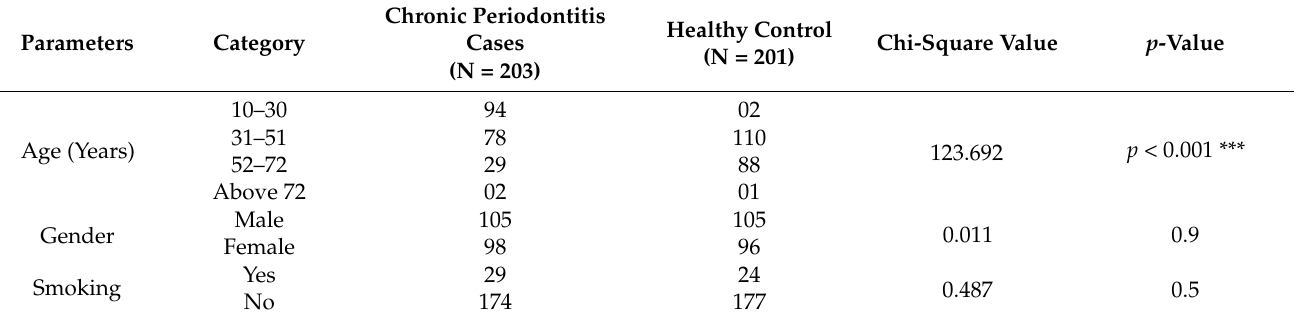
Table 4. Analysis of the studied demographic parameters and their association with chronic Peri- odontitis. The p -value indicates the results of the chi-square test calculated for each